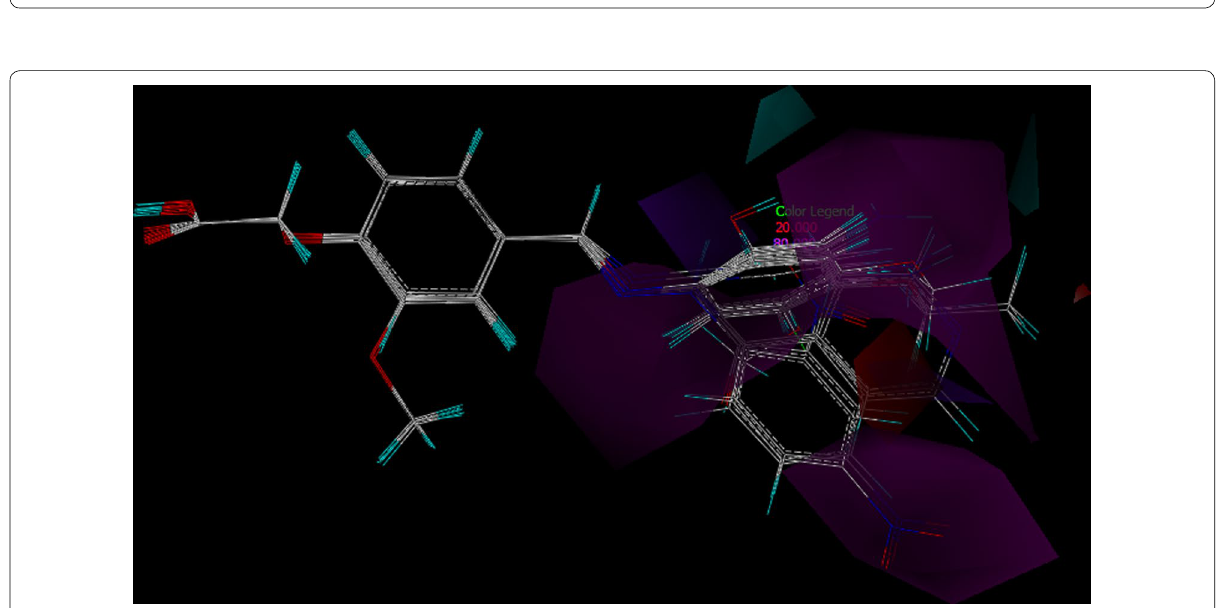
Fig. 10 CoMSIA hydrogen bond donor and hydrogen bond acceptor SD hydrogen bond donor increase activity and violet contours indicate regions where hydrogen bond donor decrease activity, whereas magenta contours indicate regions where hydrogen bond acceptors increase activity and red contours indicate regions where hydrogen bond donors decrease